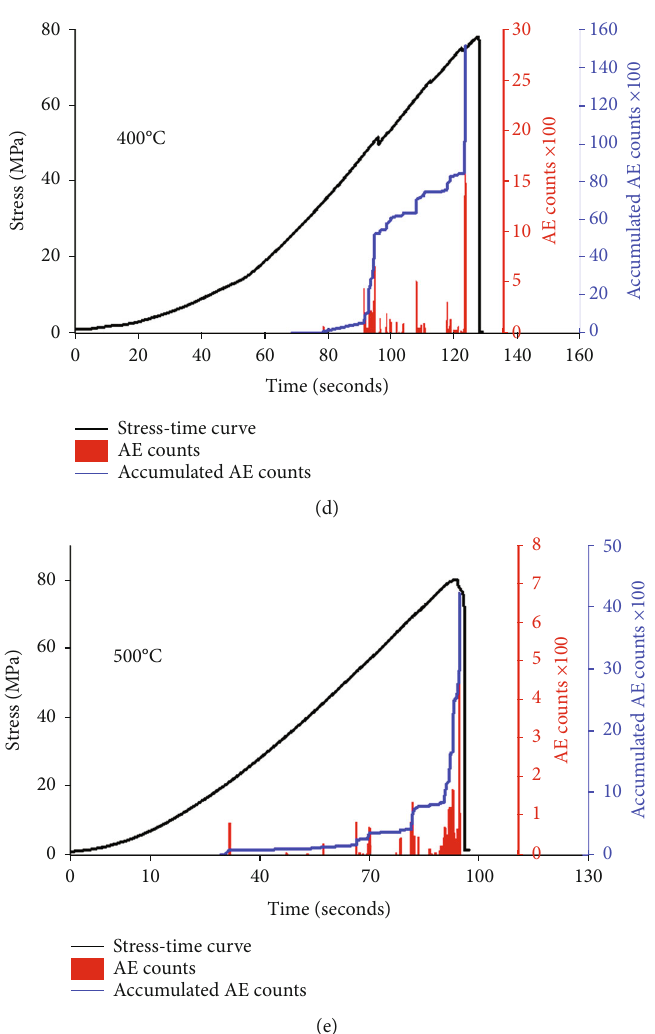
Figure 8: Typical stress – strain curves and acoustic emission counts for granite samples at high temperatures. (a) 20 ° C; (b) 200 ° C; (c) 300 ° C; (d) 400 ° C; (e) 500 °